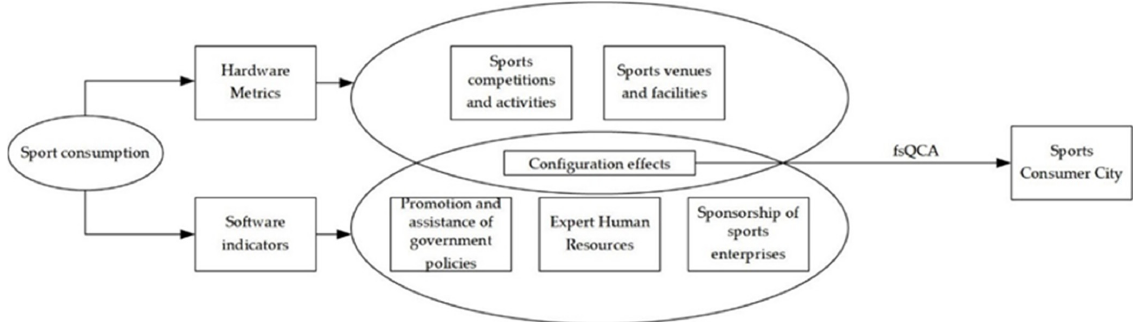
Figure 1. Theoretical model for sustainable development of sports-consuming cities in China.